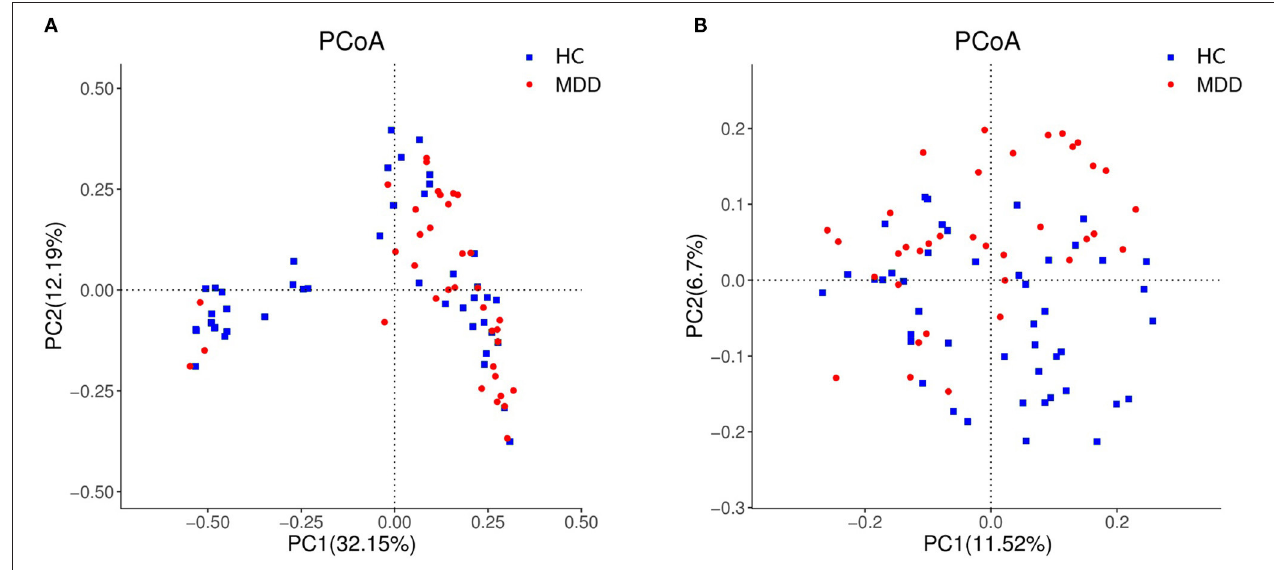
FIGURE 1 | Beta diversity as a principal coordinate analysis (PCoA) plot based on Bray–Curtis dissimilarity (A) and Jaccard dissimilarity (B) .